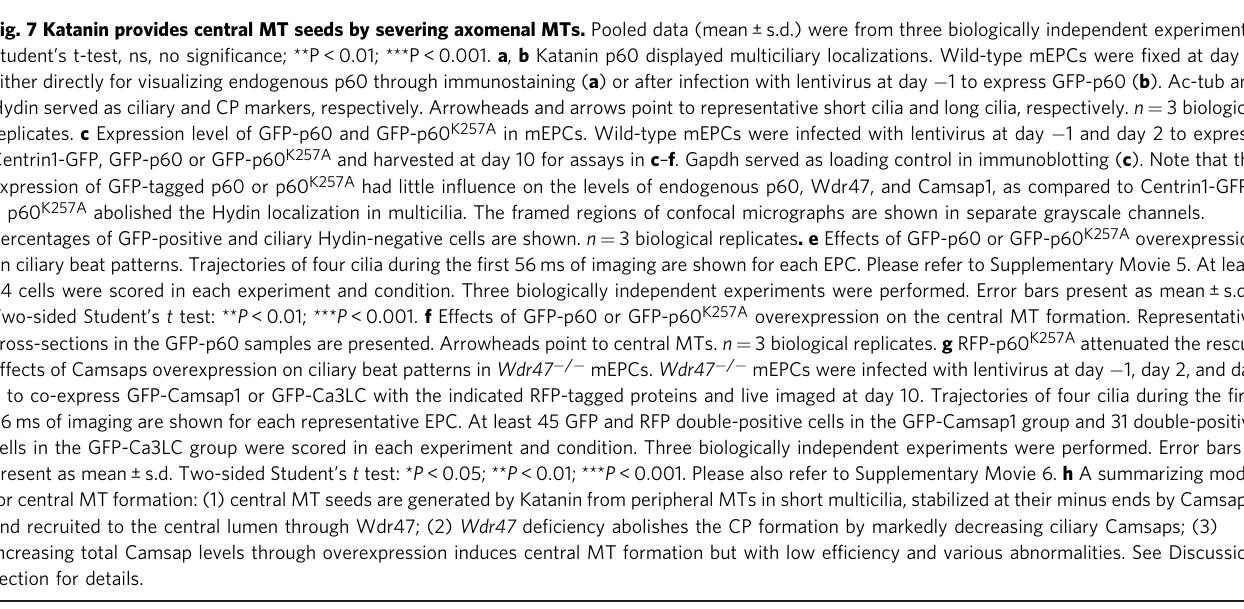
Fig. 7 Katanin provides central MT seeds by severing axomenal MTs. Pooled data (mean ± s.d.) were from three biologically independent experiments. Student ’ s t-test, ns, no signi fi cance; **P < 0.01; ***P < 0.001. a , b Katanin p60 displayed multiciliary localizations. Wild-type mEPCs were fi xed at day 7 either directly for visualizing endogenous p60 through immunostaining ( a ) or after infection with lentivirus at day − 1 to express GFP-p60 ( b ). Ac-tub